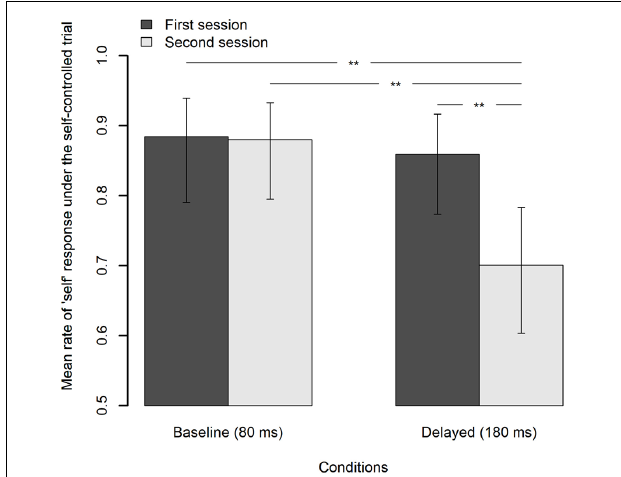
FIGURE 9 | Mean rate of “self” response under the self-controlled trials for each feedback delay and each session, in which the feedback delay is fixed to 80 ms. The error bar represents a 95% confidence interval of the mean. ** p <